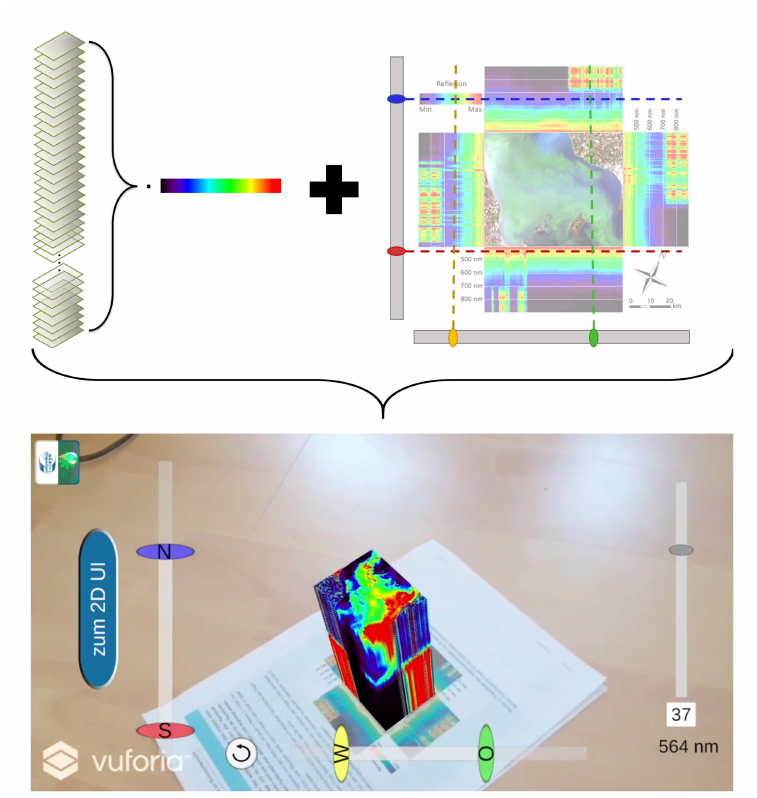
Figure 12. Implementation of the image stack with special rainbow coloring and edge transparency. (Source: